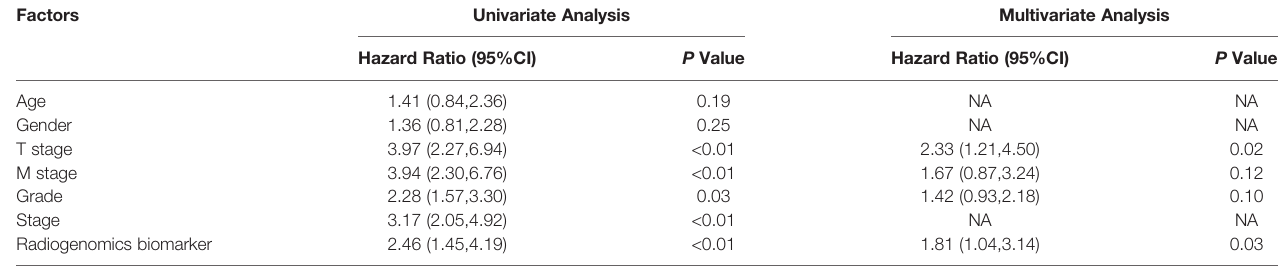
TABLE 2 | Uni- and multivariable cox regression analysis of predictors of overall survival in cohort 2. Factors